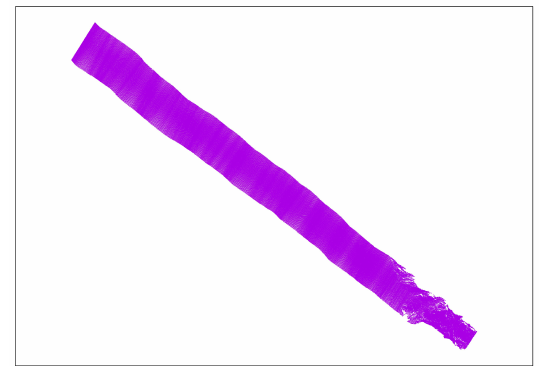
Figure 16. DDR thinning method of 5% thinning